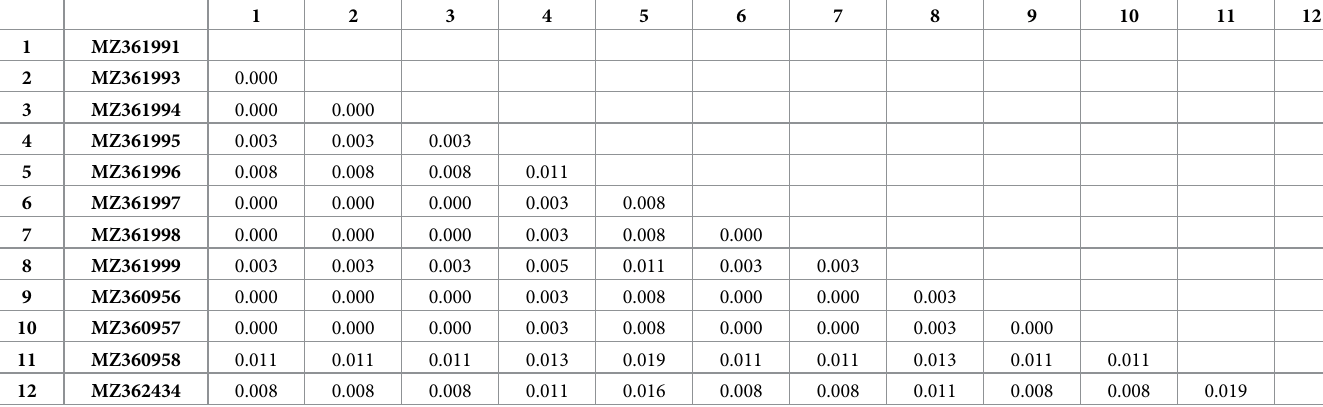
Table 3. Pairwise genetic distance matrix of cox 1 sequences between 12 isolated Enterobius vermicularis . Evolutionary analysis was conducted in MEGAX by using the Kimura 2-parameter model. The number of base substitutions per site from between sequences is shown.